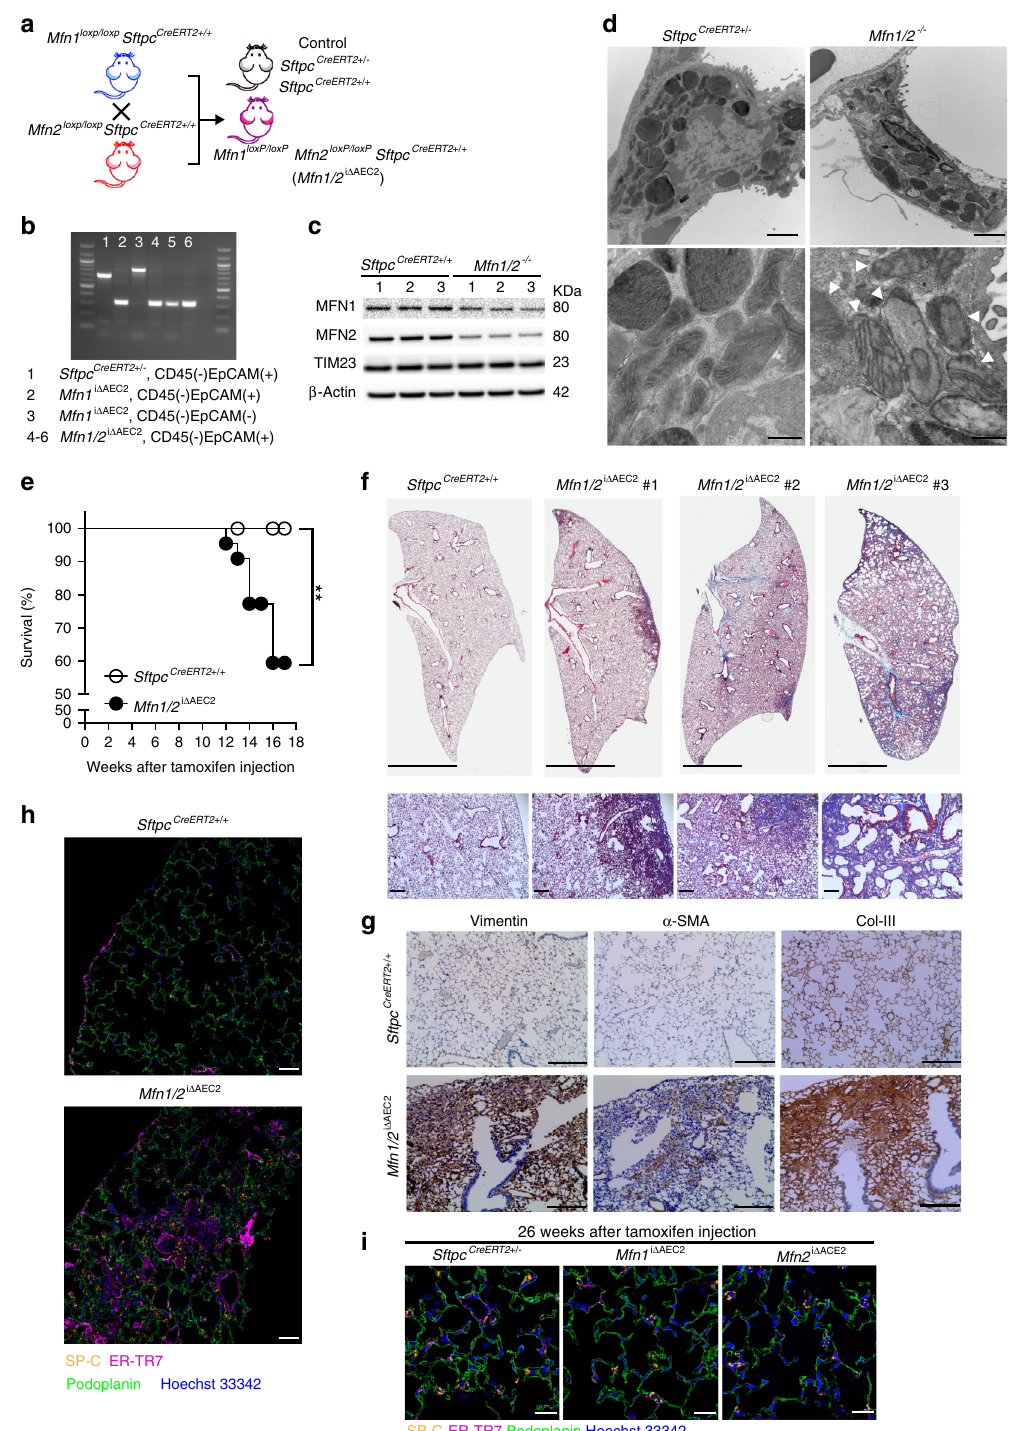
enrichment analysis of these overlapping genes con fi rmed that altered purine metabolism and oxidative phosphorylation are common biological processes altered in Mfn1/2 − / − AEC2 cells and in AEC2 cells after bleomycin treatment (Supplementary Fig. 12c). Gene-set enrichment analysis (GSEA) based on the Kyoto Encyclopedia of Genes and Genomes (KEGG) database further revealed that Mfn1/2 − / − AEC2 cells, compared with AEC2 cells after bleomycin treatment, markedly enhance the upregulation of purine metabolism (Supplementary Fig. 12d).